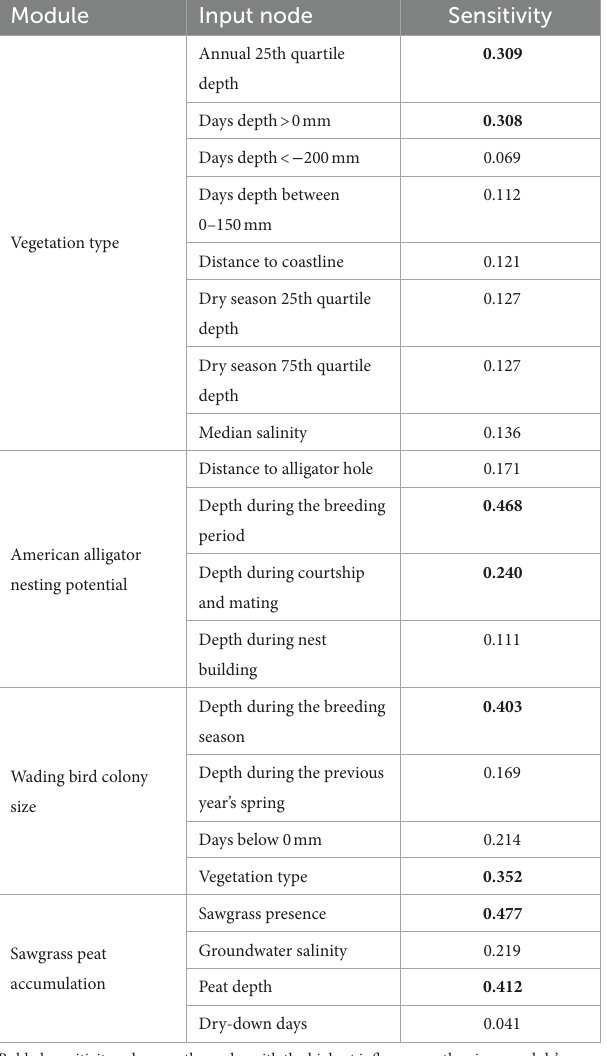
TABLE 4 One-way sensitivity analysis results for each Everglades vulnerability analysis (EVA) module’s input nodes.